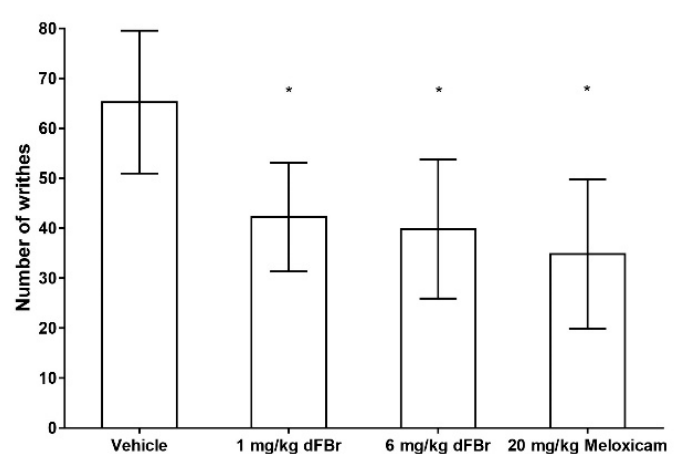
Figure 3. Desformylflustrabromine significantly decreases the number of writhes in the writhing test. The number of writhes is expressed as mean ( ± S.D.). Statistical significance was considered as * p < 0.05. Twelve mice were included in each treatment group ( n = 12).